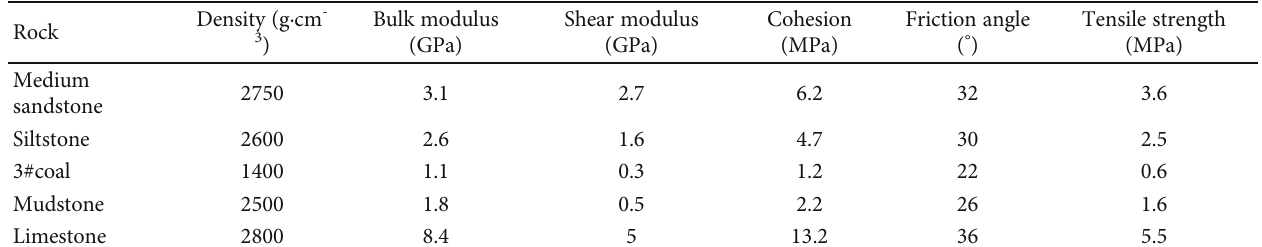
Figure 10: Layout of the working face and the monitoring plane. Table 2: The geomechanical parameters of each